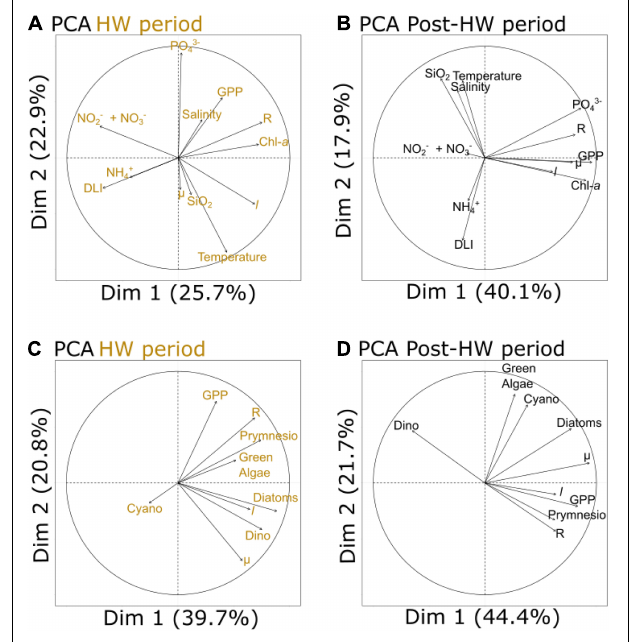
FIGURE 5 | Principal component analyses (PCA) of the log response ratio (LRR) of metabolic and environmental variables during the HW period (A) and the post-HW period (B) , as well as PCA of the LRR of metabolic variables and PFTs during the HW period (C) and the post-HW period (D) . When variables are close to each other, they are positively correlated. When they are opposed, they are negatively correlated. When they are orthogonally located, they are not correlated. When variables are close to the center, they are not well represented by the